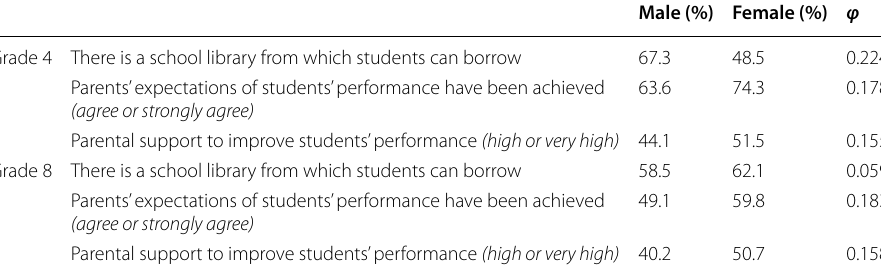
All differences are statistically significant at the .001